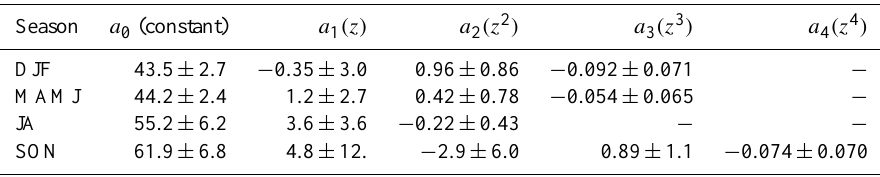
∗ The vertical profiles were constructed from a polynomial fit of the 1km binned CGOP observations in each season. The number of polynomial terms in each season was chosen to minimize the residual error and maximize the adjusted r 2 , and the resultant coefficients are shown here along with their 95% confidence intervals. All fits are statistically significant at the p = 0 . 01 level or better. The fitted vertical profile in each season, shown in Fig. S6, can be reconstructed